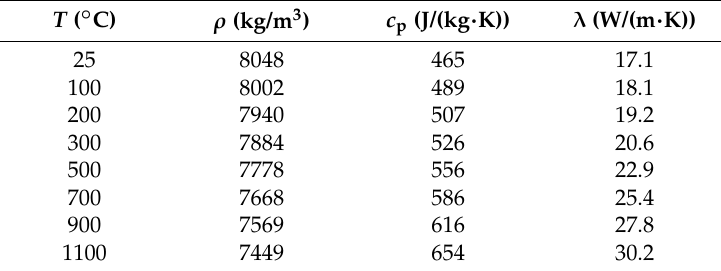
Table 3. Austenite physical properties.